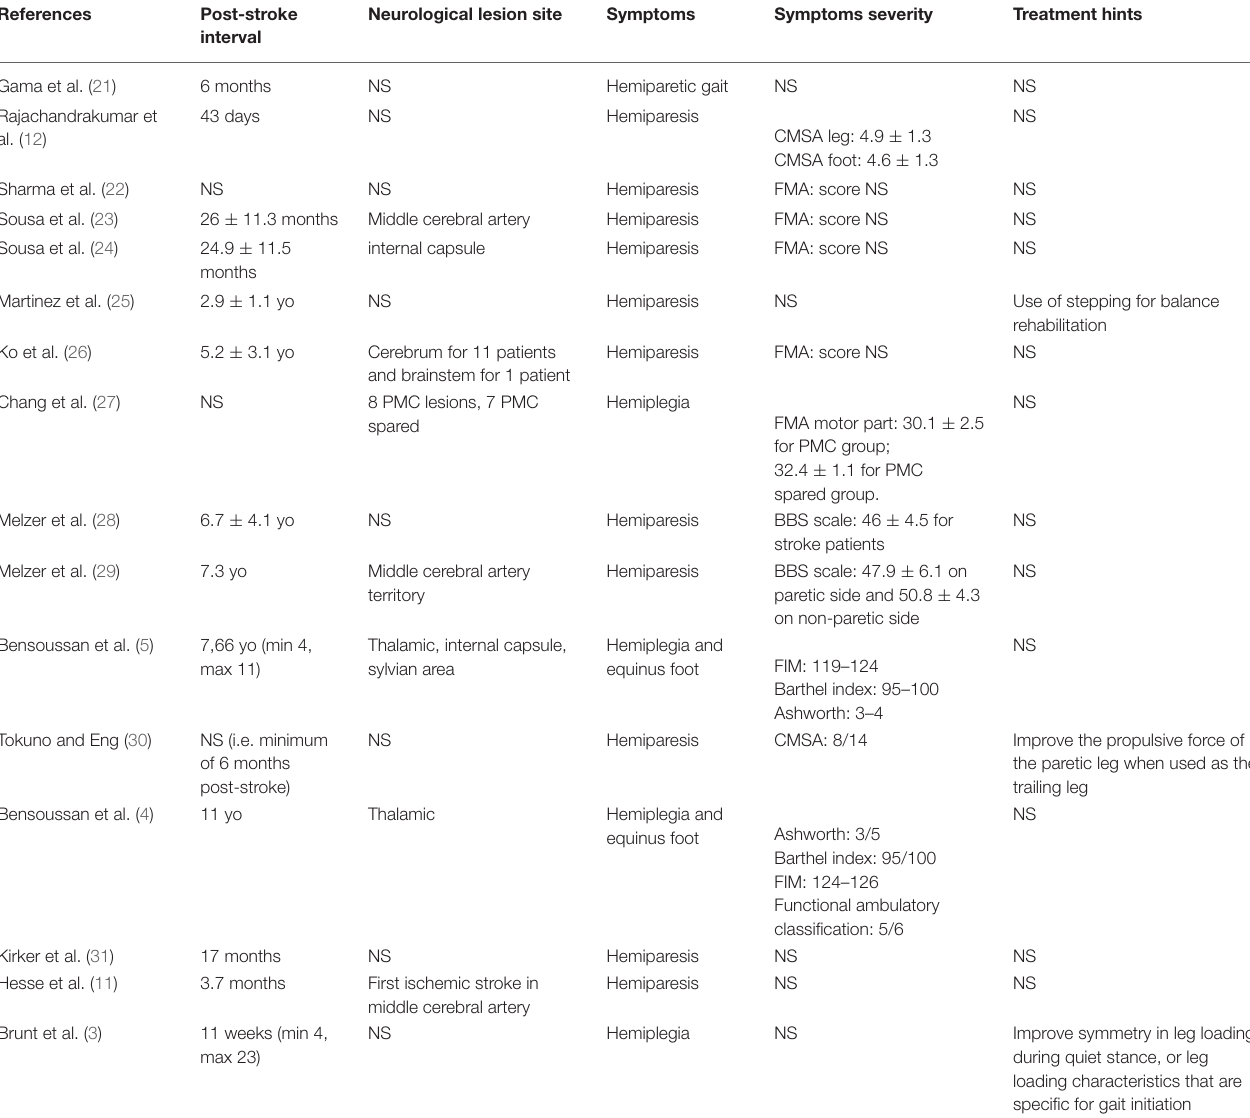
TABLE 1 | Clinical characteristics of the population in the selected